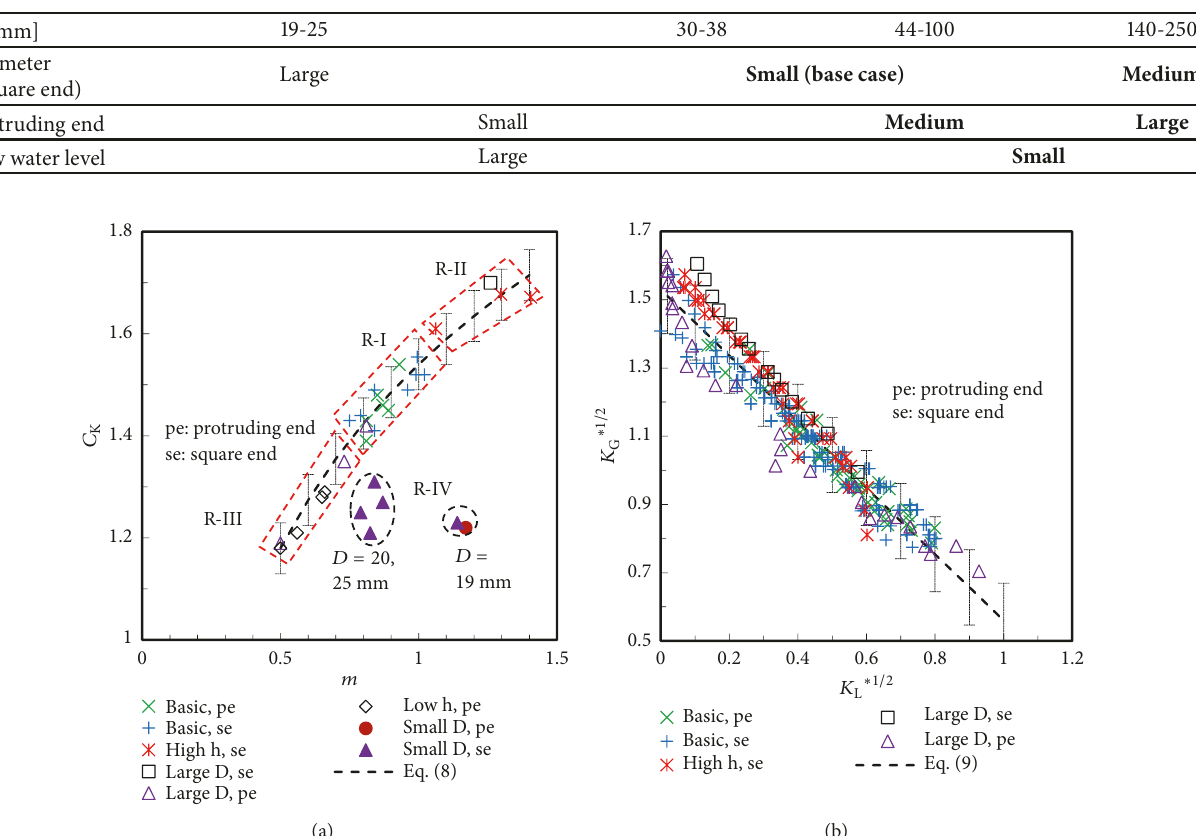
Figure 8: Features of CCFL at the square top end: (a) relationship between 𝐶 K and m (classifications: cf. Table 1) and (b) CCFL for medium and large